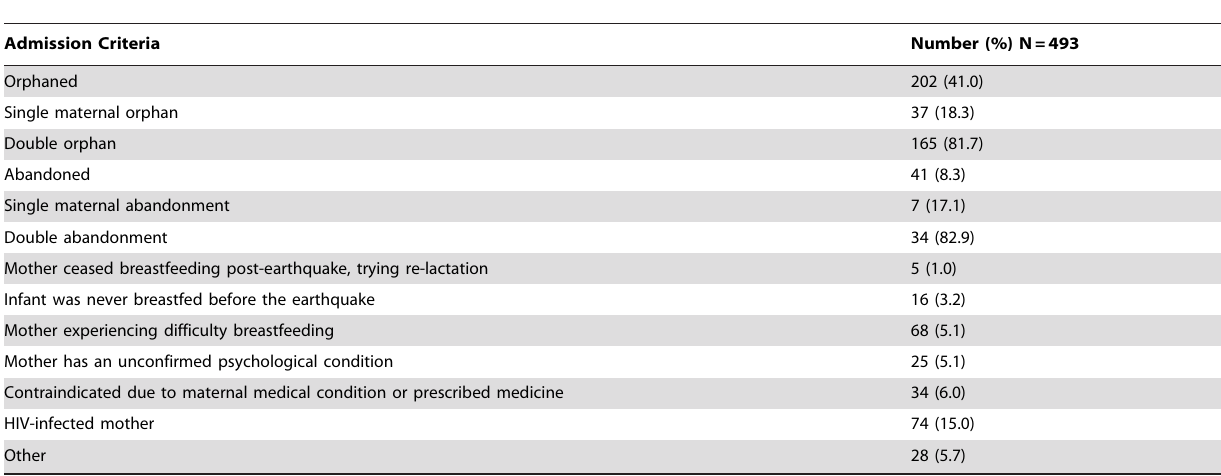
Table 1. Recorded Criteria for Admission into RUIF Program among Infants, April–June